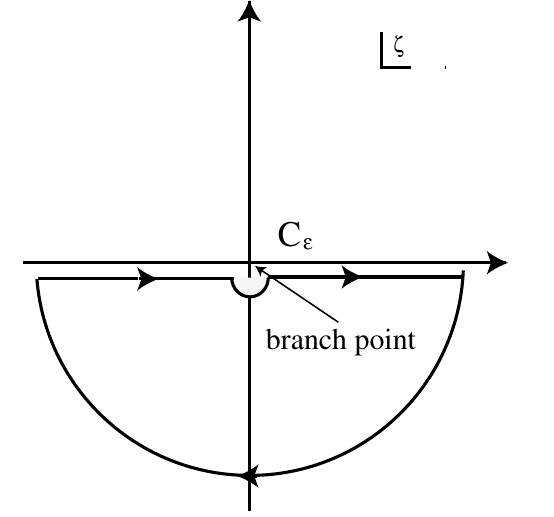
FIG. 10. The path of integration in Eq. (D8) in order to prove Eq.